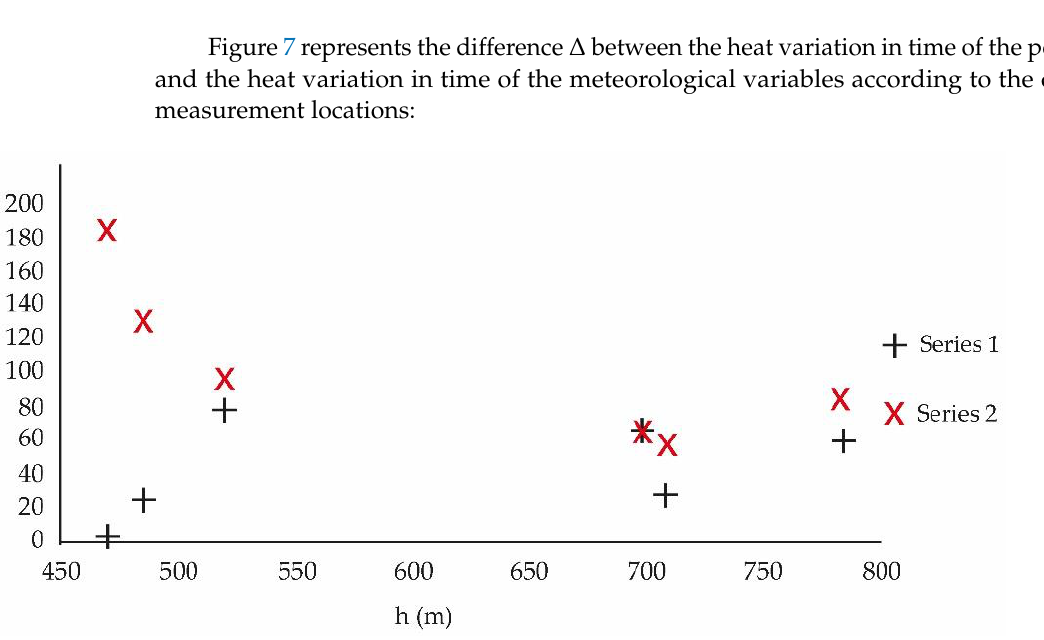
Figure 7. Represents the height of the different measurement locations and the difference in temporal heat between pollutants and meteorological variables according to periods 2010 – 2013 (Series 1) and 2017 – 2020 (Series 2) for a basin configuration.